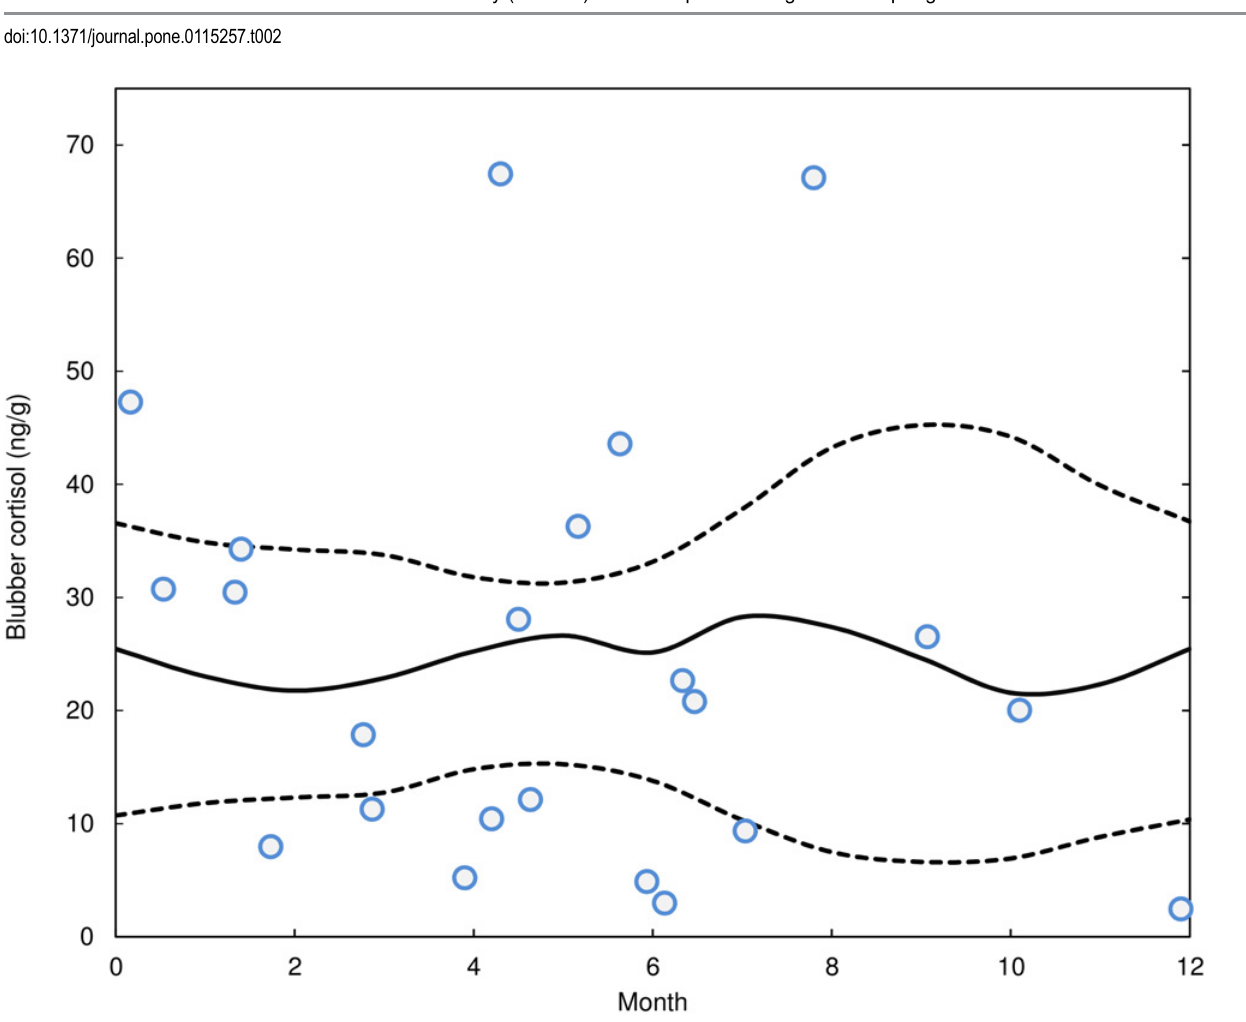
Fig 4. Results of a seasonal analysis of blubber cortisol levels in stranded D . delphis . The open circles represent cortisol concentrations for each individual. The observed three-month-running averages were calculated for each month (see text) and represented by the solid line. The dotted lines represent the 95% confidence envelope for the total seasonal randomness, i.e., the cortisol measurements were randomized relative to sampling date in 10,000 permuted datasets from which three-month-running averages were calculated. All observed three-month-running average values (represented by the solid line) are contained within the 95% confidence interval of the randomized null distributions indicating there was no evidence of seasonal fluctuations in blubber cortisol